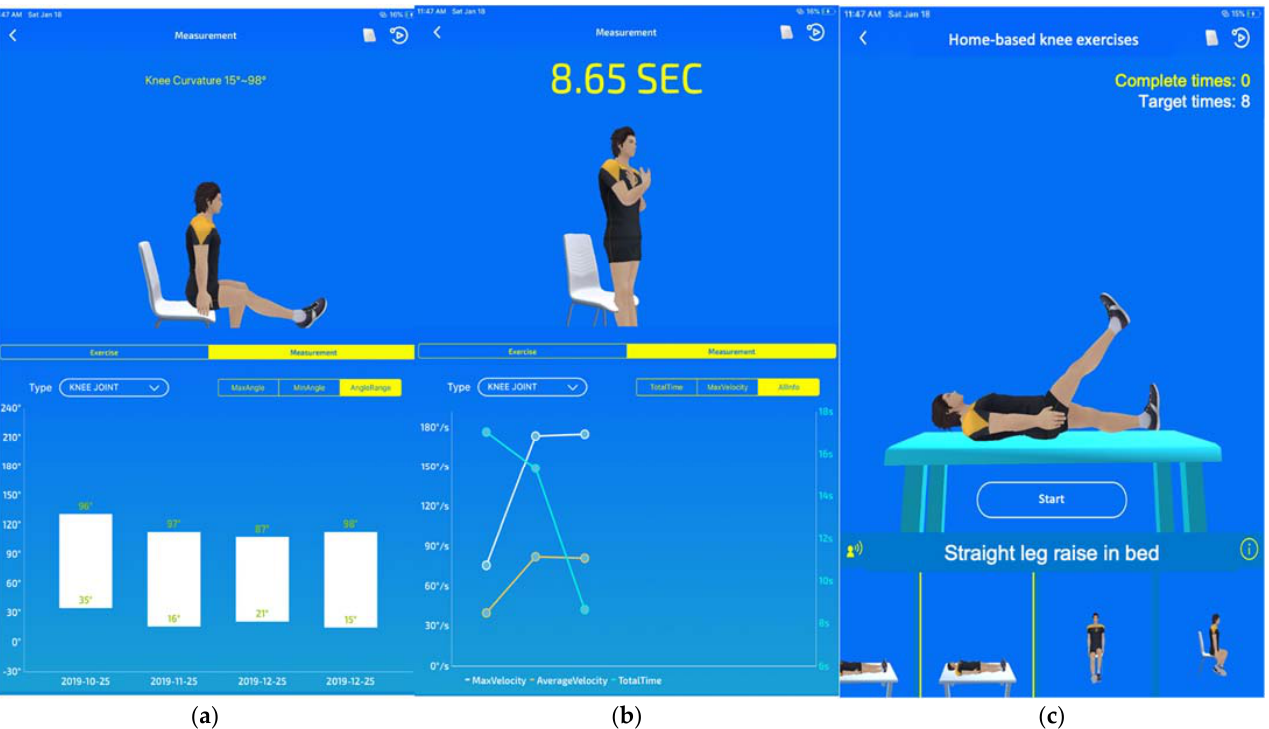
Figure 2. Mobile app for patients: ( a ) historical records of knee flexion and extension; ( b ) historical records of 5TSST; ( c ) daily home-based exercise tasks.